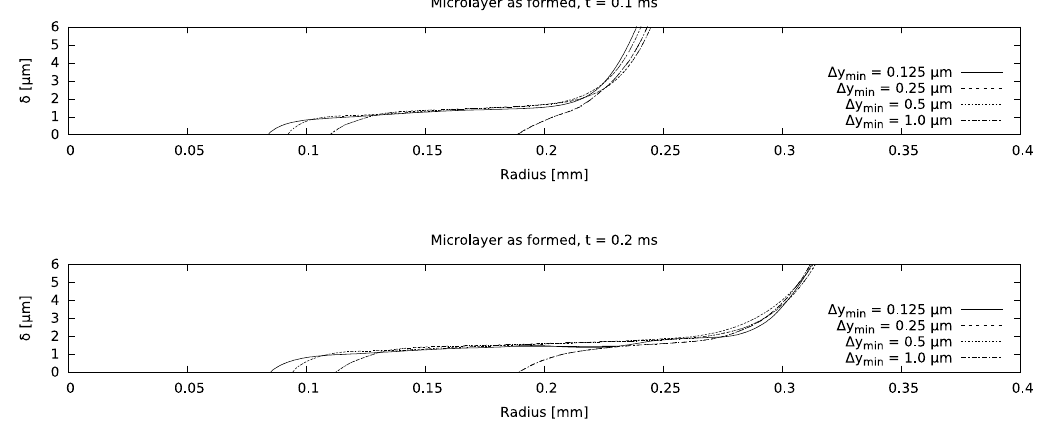
Figure 7. Mesh sensitivity study for the water boiling case.